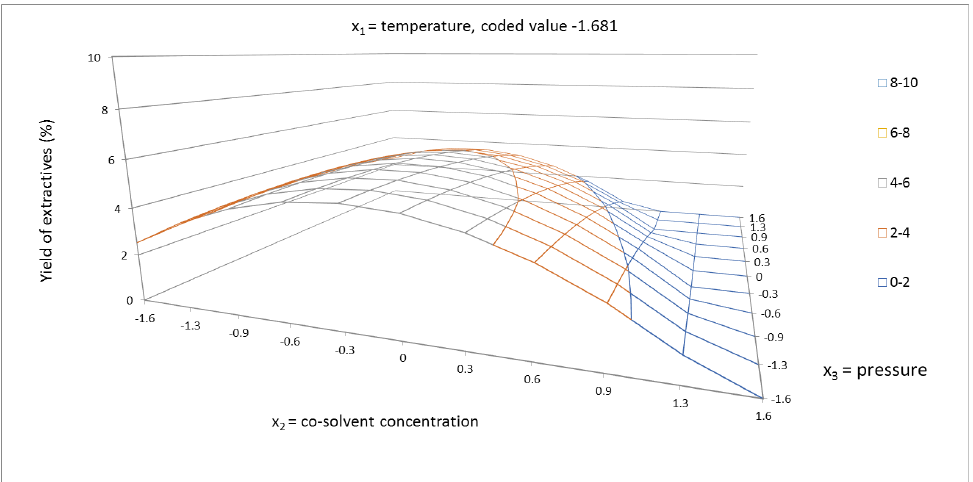
Figure 2. Response surface of extractives yield (%) as a function of cosolvent concentration of 40–96.6% EtOH / water and pressure in the range of 1050–9000 psi, in coded values, at constant temperature of 70 °C (coded value −1.681).